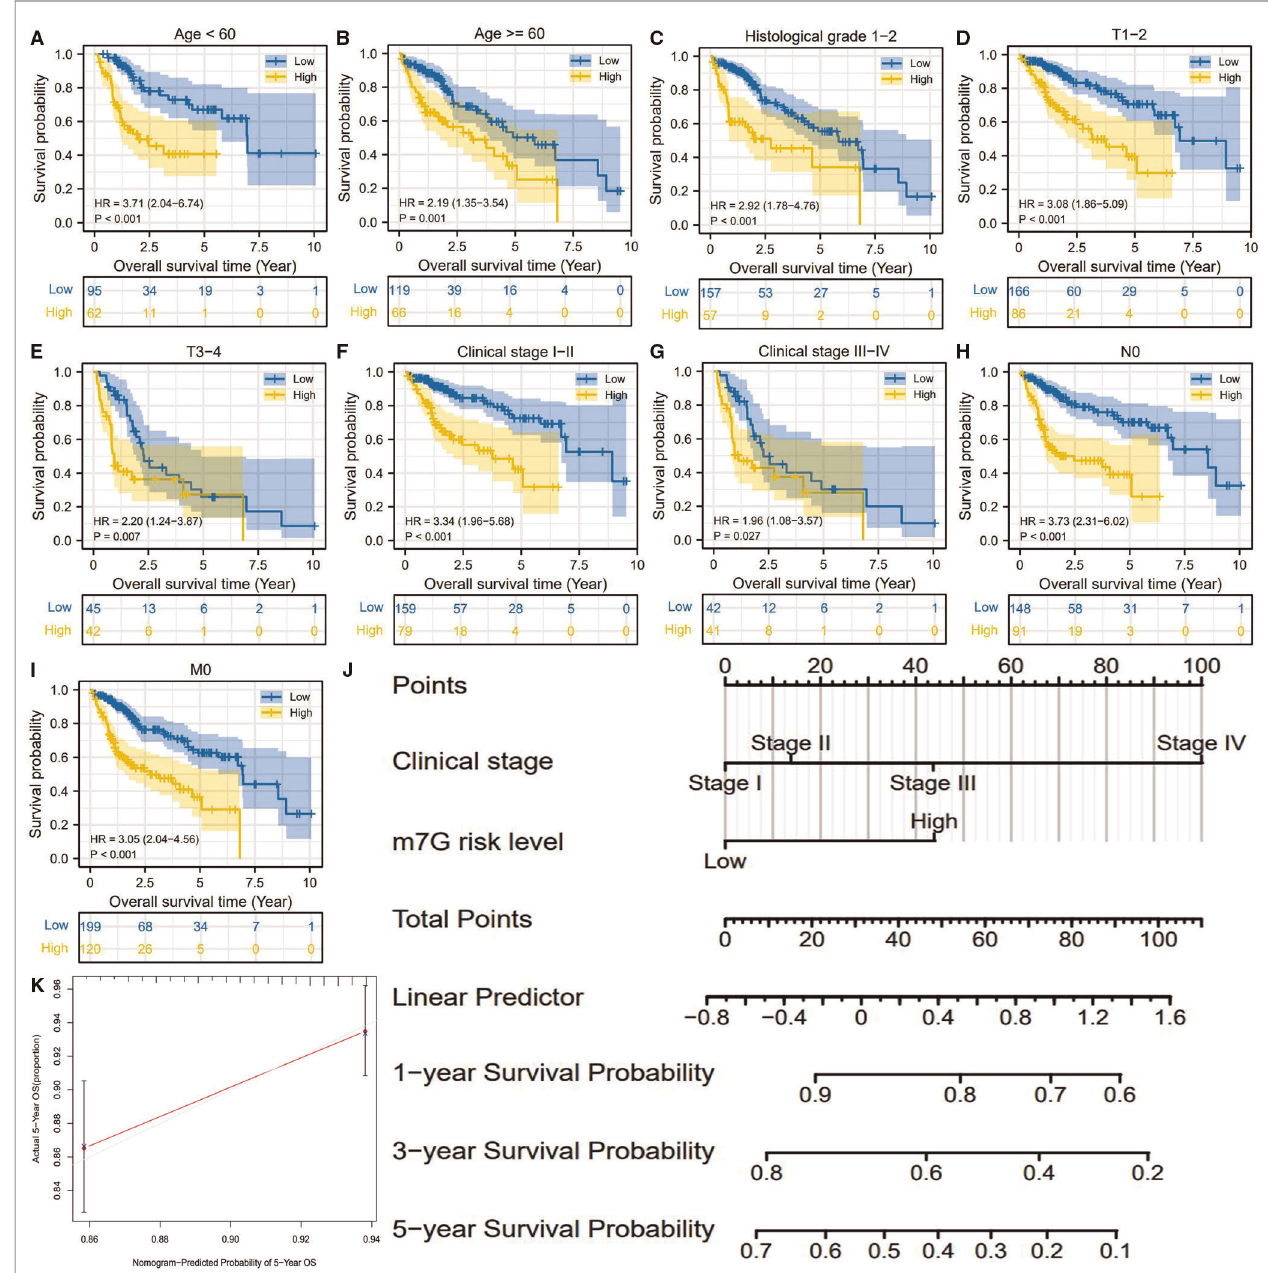
FIGURE 4 | m7G risk signature is available for most of the clinical subgroups. ( A – I ) Overall survival difference between high- and low-m7G-risk groups in each clinical subgroup. ( J ) Nomogram is used for predicting 1-, 3-, 5-year overall survival probability of HCC patients. ( K ) Calibration curves for evaluating the predictive accuracy of the m7G